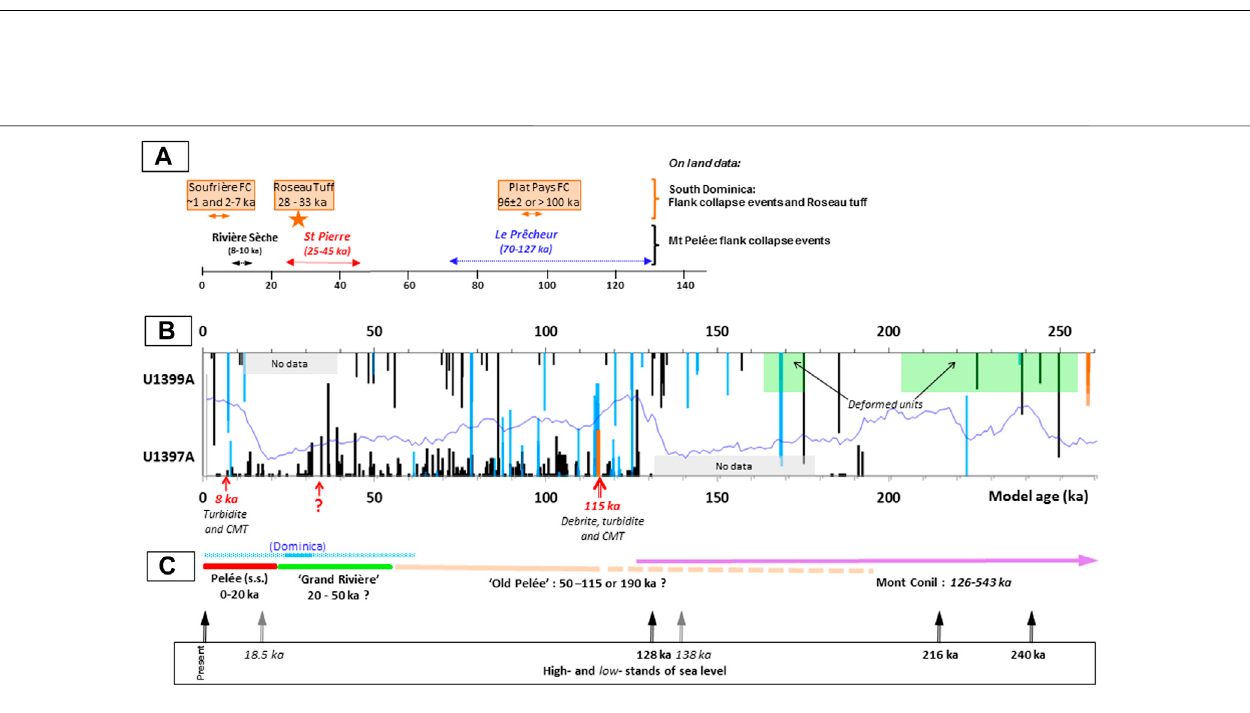
Frontiers in Earth Science |